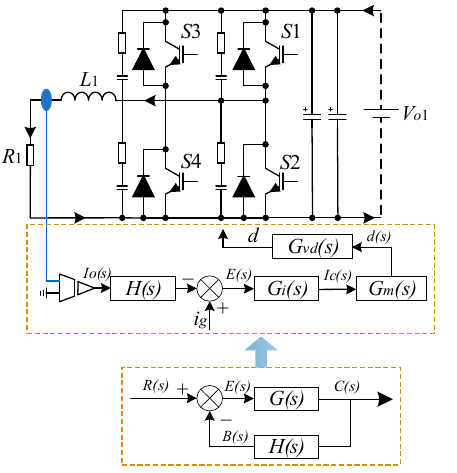
To reduce the influence of the phase margin correction effect, we added the closed- loop PI control algorithm, and then obtained K p = 0.03 and K I = 9.6.